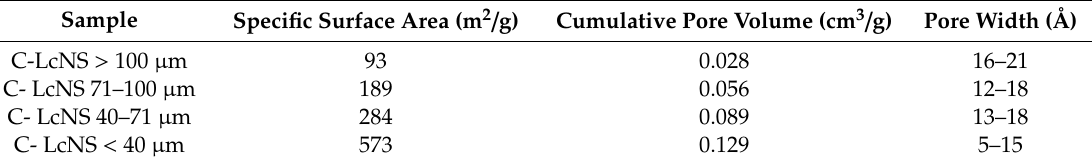
Table 2. Specific surface area, cumulative pore volume and pore width of the C-LcNS.